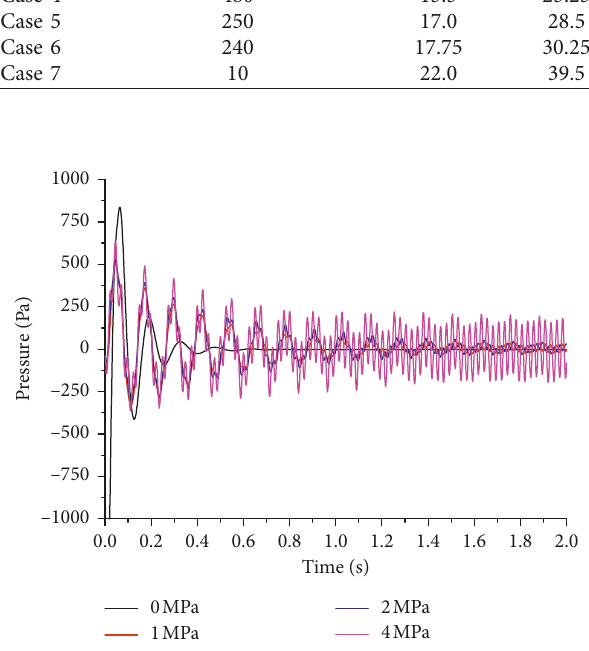
Figure 11: Vibration waveforms of MP3 in Case 7 under four different pressures.